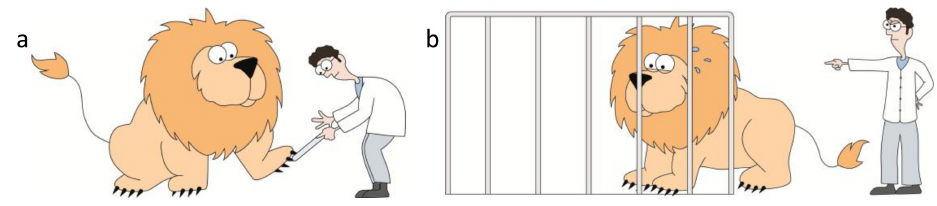
Figure 1. Safe-by-Design strategies: ( a ) Design out hazard and ( b ) Reduce